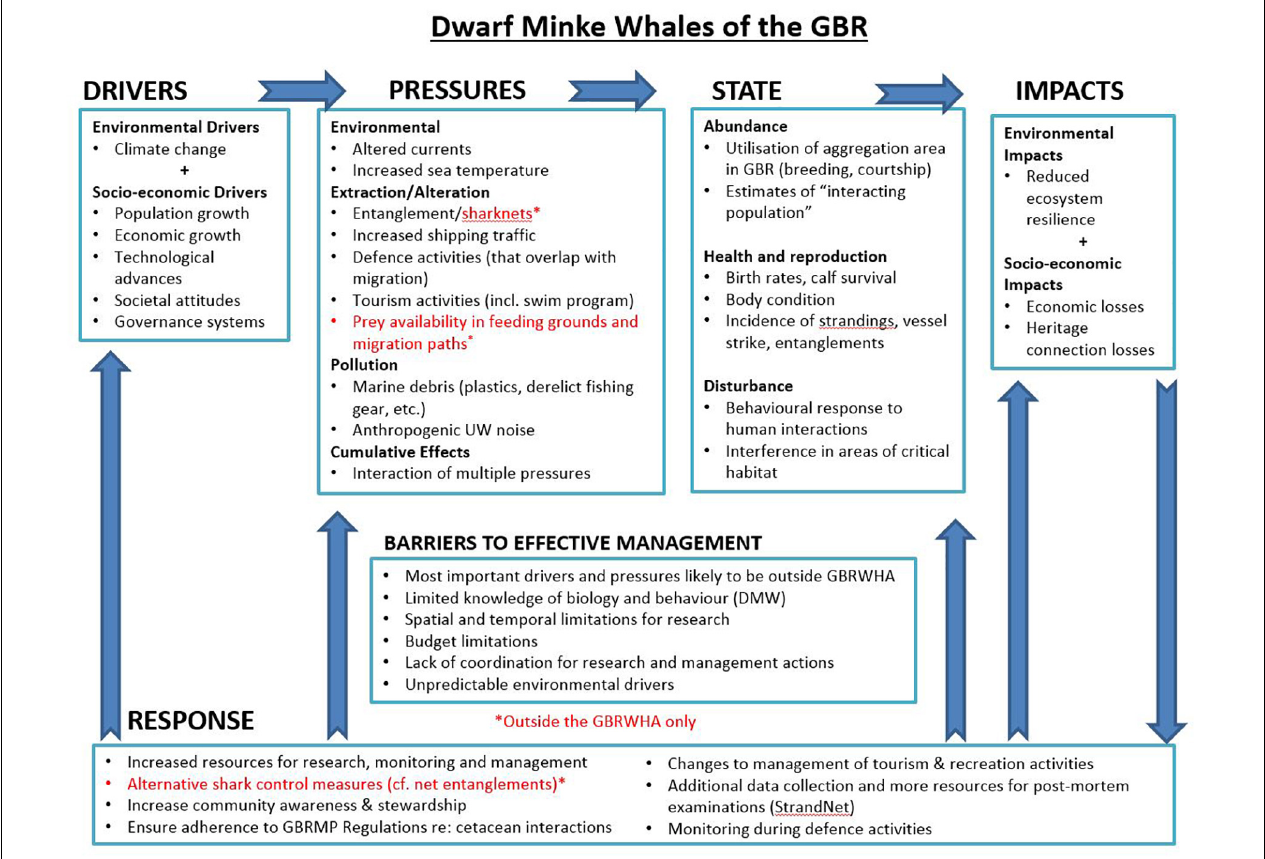
FIGURE 3 | Example Driver, Pressure, State, Impact, and Response (DPSIR) flowchart identifying system components and relationships relevant to integrated monitoring of dwarf minke whales in the Great Barrier Reef World Heritage Area (adapted from Curnock et al., 2018, for illustrative